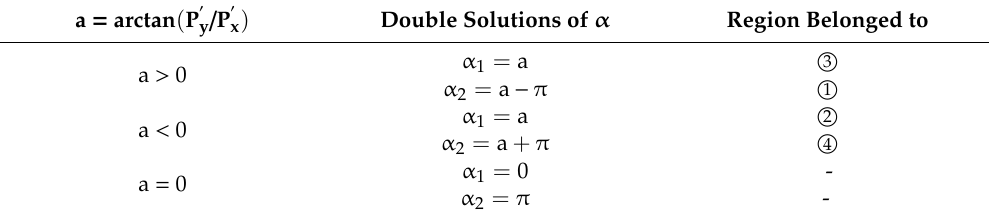
Table 2. The solutions of the joint angle of the